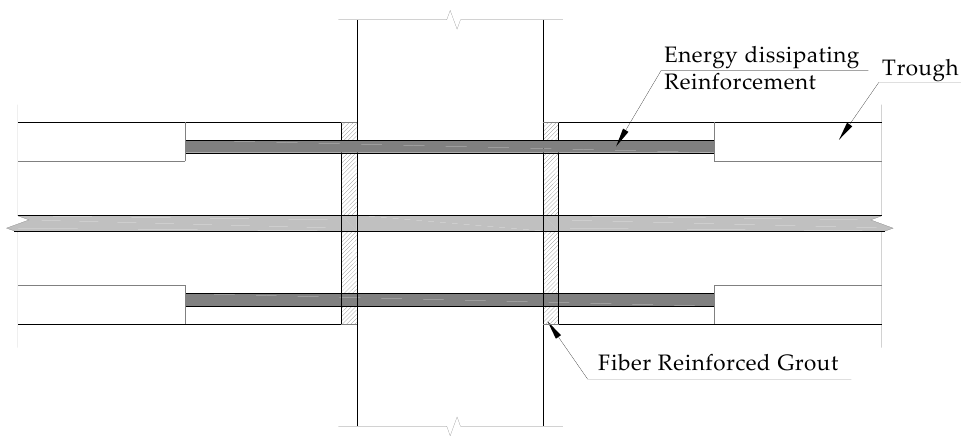
Figure 18. Five test specimens with various variables.